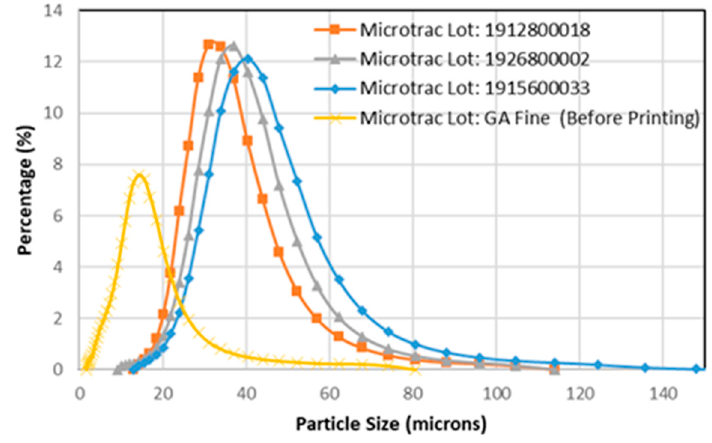
Figure 3. D10, D50, and D90 size characterization of the four powder lots selected in the study.